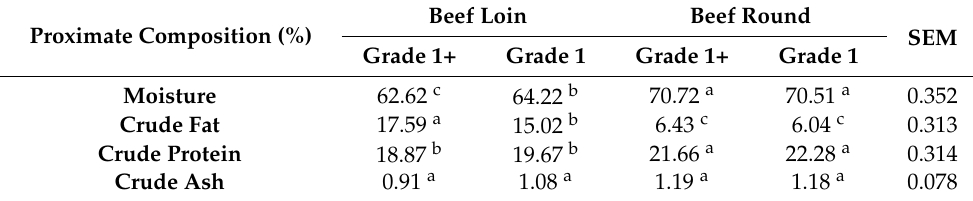
Table 2. Proximate composition of beef loin and round.